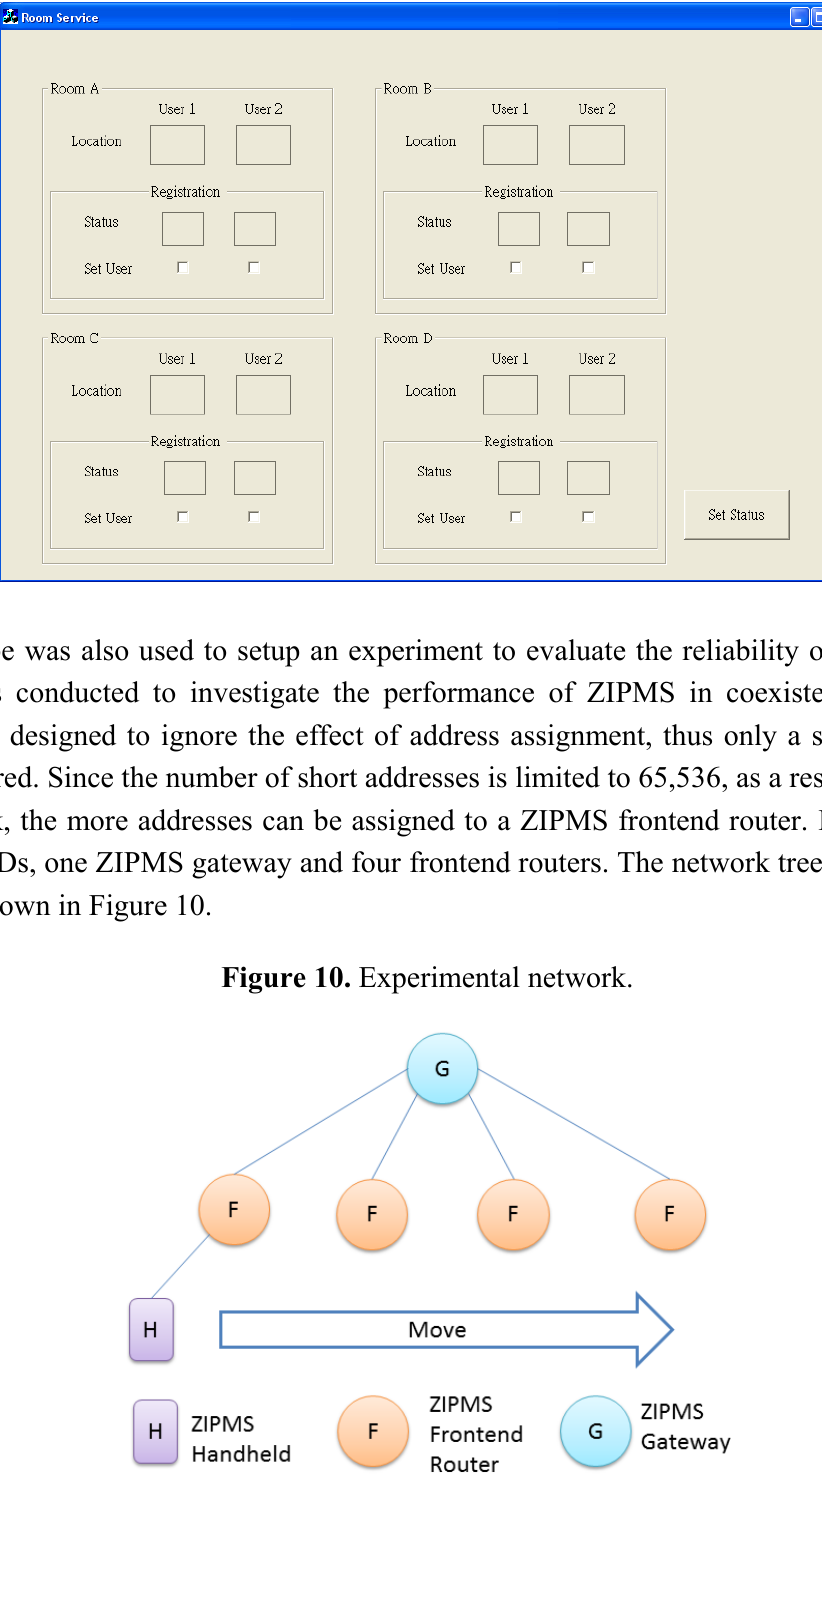
Figure 9. User interface of the ZIPMS prototype.